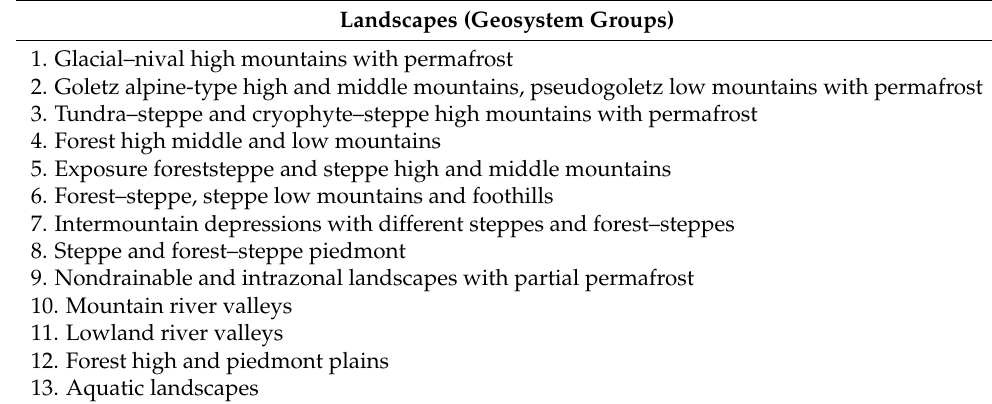
Table 1. Identified types of landscapes of the Altai-Sayan mountain country